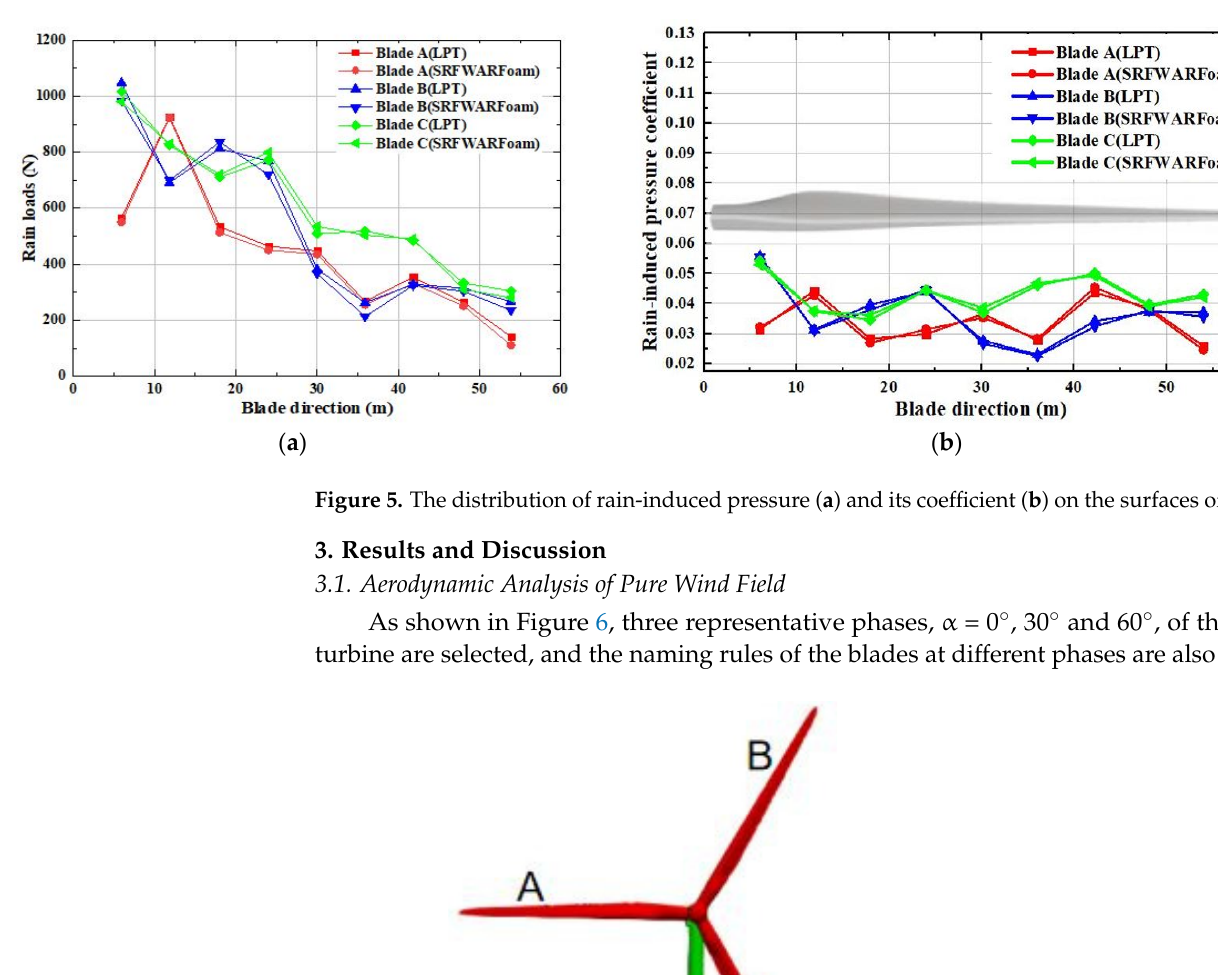
Figure 6. Schematic diagram of wind-turbine phase angle and blade naming. Generally, for the tower, the area of the blade-radius erosion cover is the disturbance area, and the other parts are the non-disturbance area [20]. The section at 20 m is taken as the typical section of the disturbance area, and the section at 80 m is the typical section of the non-disturbance area. Figure 7 shows the wind-pressure contour map of the typical section under the wind speed of 10 m/s at different phase angles, and the value on the contour is the relative value after dimensionless treatment. Figure 8 analyzes the circum- ferential-pressure-coefficient distribution of two typical sections of the tower under dif- ferent conditions. Through analysis, it can be found that when the wind-turbine phase angle is 0°, the blade completely blocks the tower, resulting in the negative pressure of the typical section of the tower. In addition, at other phase angles, the position of the maxi- mum positive pressure on the tower is 270°, and the position of the maximum negative pressure is 0°. The farther the blade is away from the tower, the less the tower force is affected by the blades.